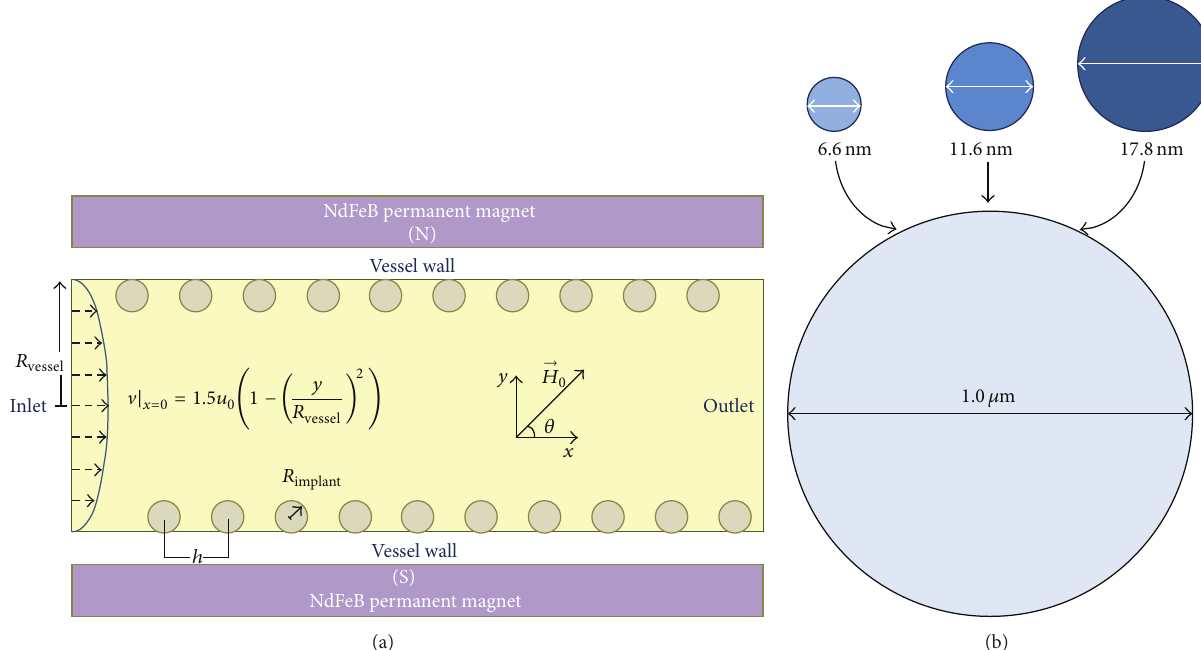
Figure 1: (a) Schematic of the CV used for studying the behaviour of SPIONs enriched MDCPs in SA-MDT system. (b) The modified magnetic force acting on MDCPs enriched with three different sizes of SPIONs is modelled in the SA-MDT system using different magnetic field strengths and blood